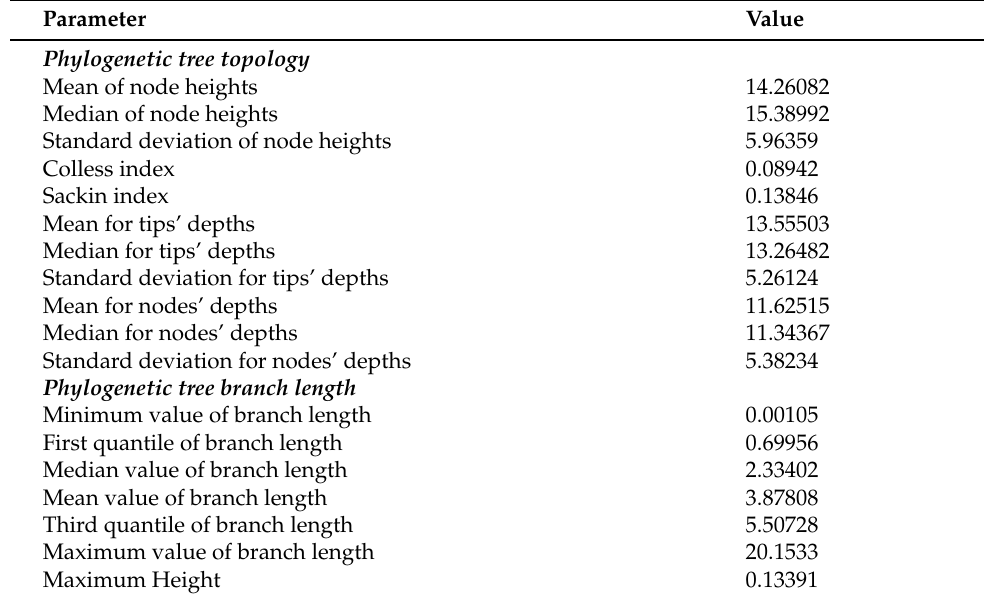
Table A6. Mean values of phylogenetic tree summary features from benchmark data.